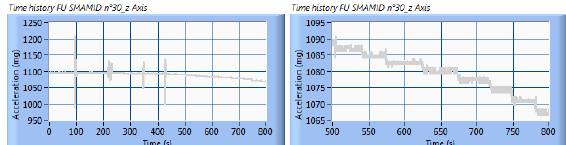
Figure 8. Time history x axis extraction at 300 gon (left) and at 299 gon (right)